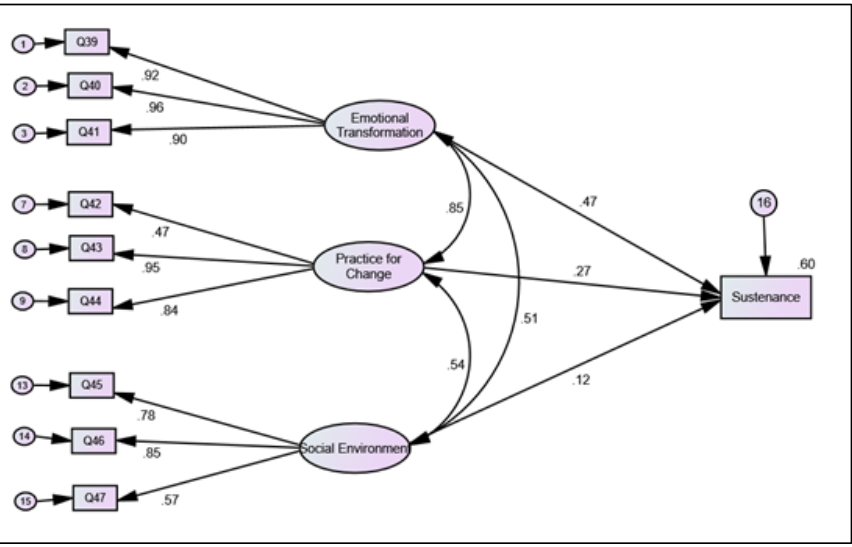
Figure 3. Structural equation modeling for sustenance of sunscreen use behavior among Florida residents.